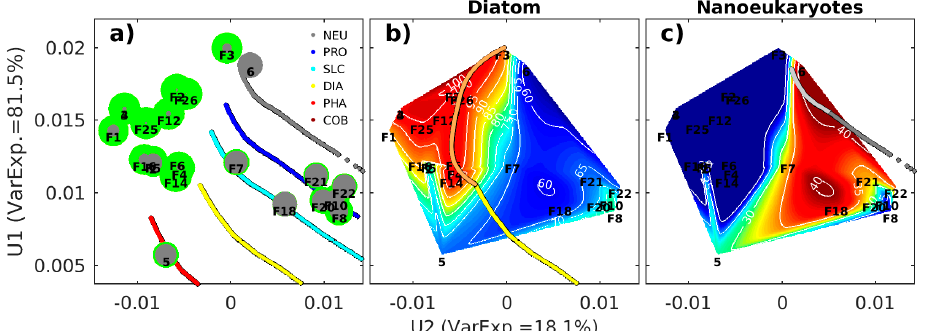
Figure 10. The dimensionless U 1 –U 2 plane obtained from the joint SVD of the synthetic matrix Rs and an R matrix composed by the matchups of nLw data corresponding to in situ measurements performed during the PHYTOFRONT cruise and in St. 18. ( a ) The relative concentration (percent of total Chl-a concentration) of Diatoms (green circles) and Nanoeukaryotes (grey circles) derived from FluoroProbe measurements associated with Diatom and Green Algae plus Cryptophyta, respectively. In ( b , c ), the colored area represents the relative concentration interpolated for Diatoms and Nanoeukaryotes, respectively, with blue (red) colors corresponding to low (high) values. The orange dots in ( b ) denote the new addition to the orthomodel for Diatoms (yellow line); the light gray dots in ( c ) denote the points excluded in the orthomodel for Nanoeukaryotes (grey line). Abbreviations are the same as in Figure 5; F-coding refers to the PHYTOFRONT stations in Figure 1.